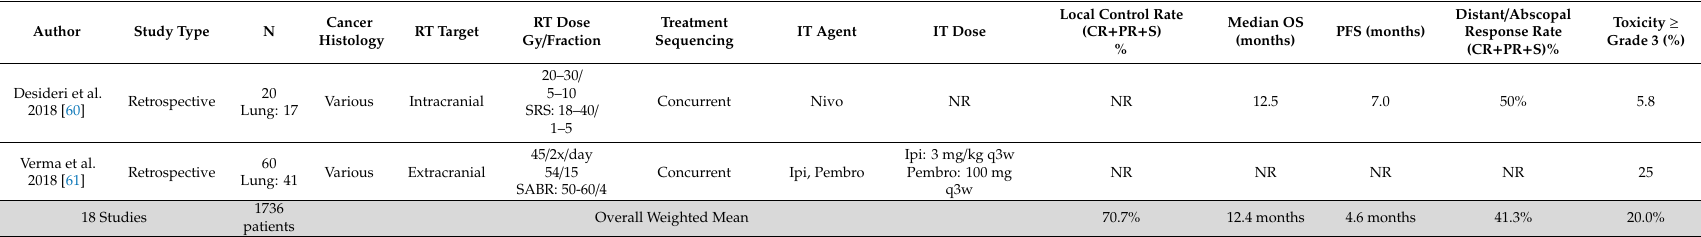
Table 1. Prospective and retrospectives trials reporting clinical results of radiotherapy and ICI combination in metastatic